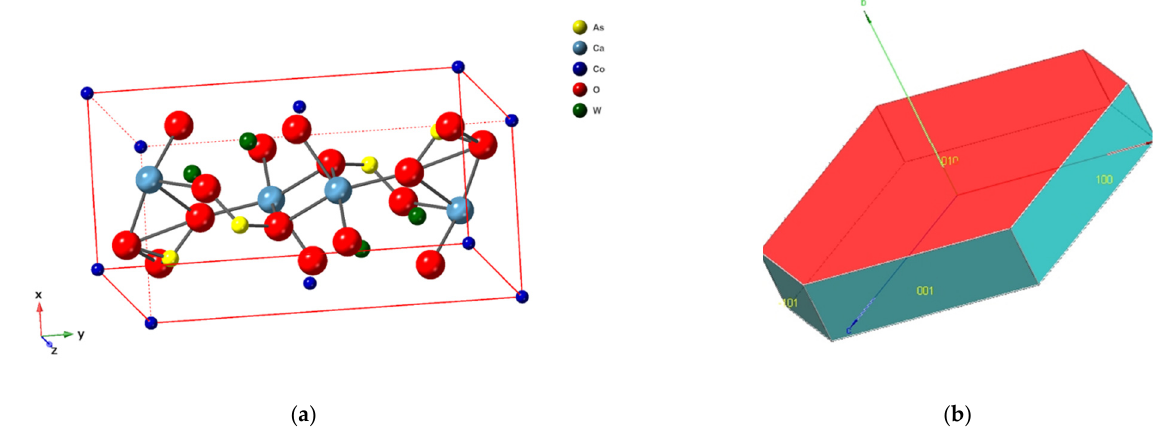
Figure 1. ( a ) Crystal structure (top) of roselite based on crystal data from Hawthorne and Ferguson [13]; ( b ) crystal form.